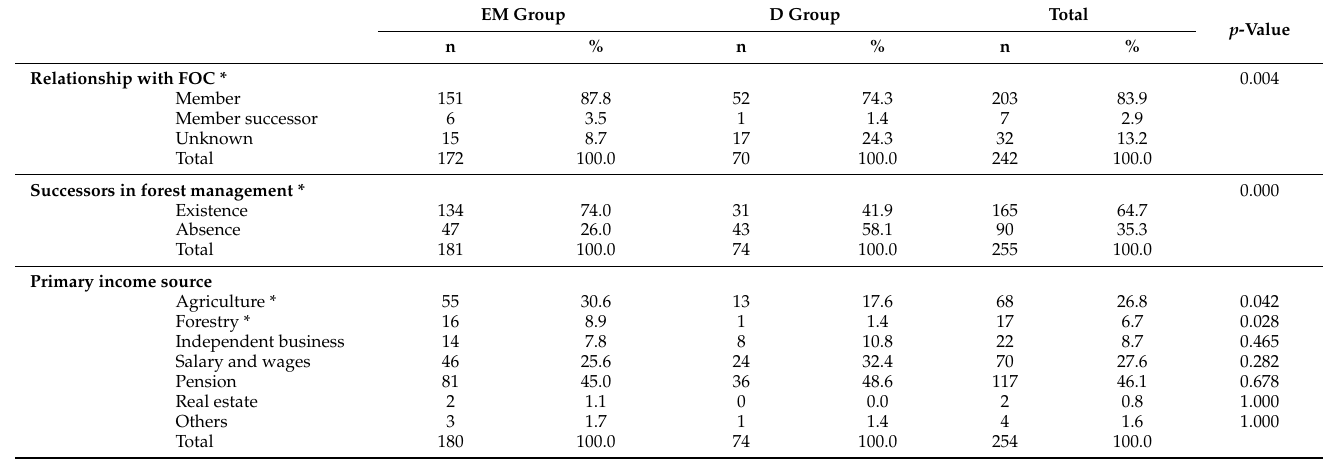
Table 9. Comparison of PFOs’ characteristics between the two groups in